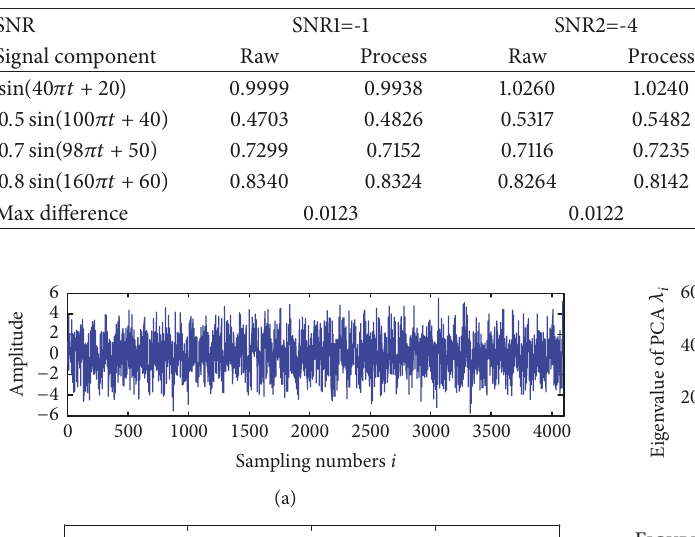
Table 1: Amplitude of signal components under the different SNR.